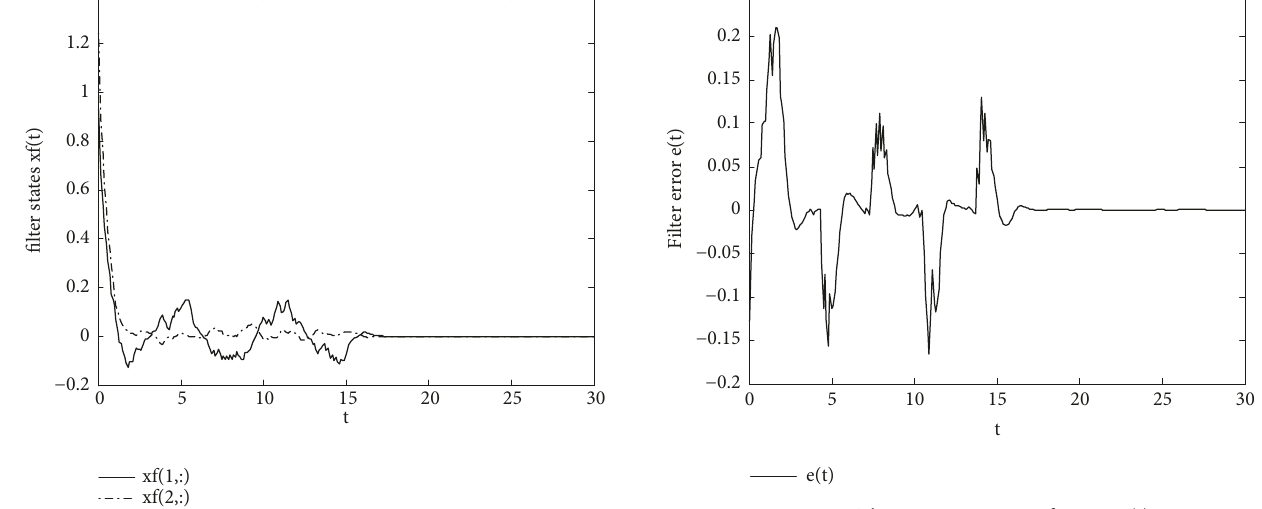
Figure 7: The response curve of system states 𝑥 𝑓1 , 𝑥 𝑓2 .